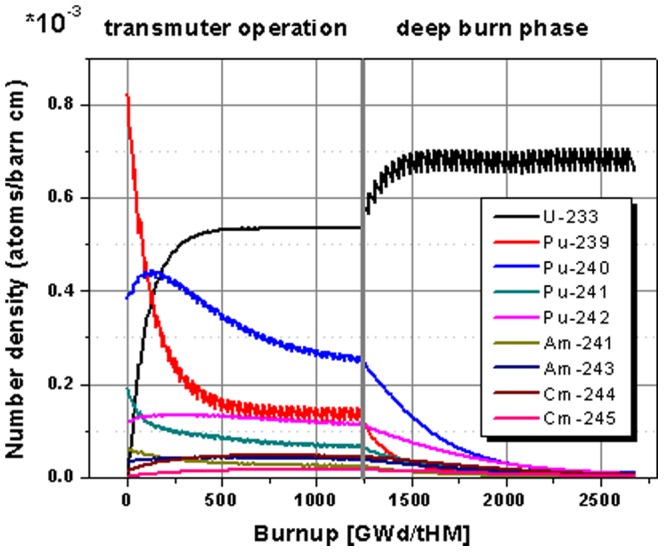
Evolution of the isotope inventory for the case based on Th-232 fertile material with TRU feed in the transmuter operation and the deep burn phase using the U-233 bred in the blanket.